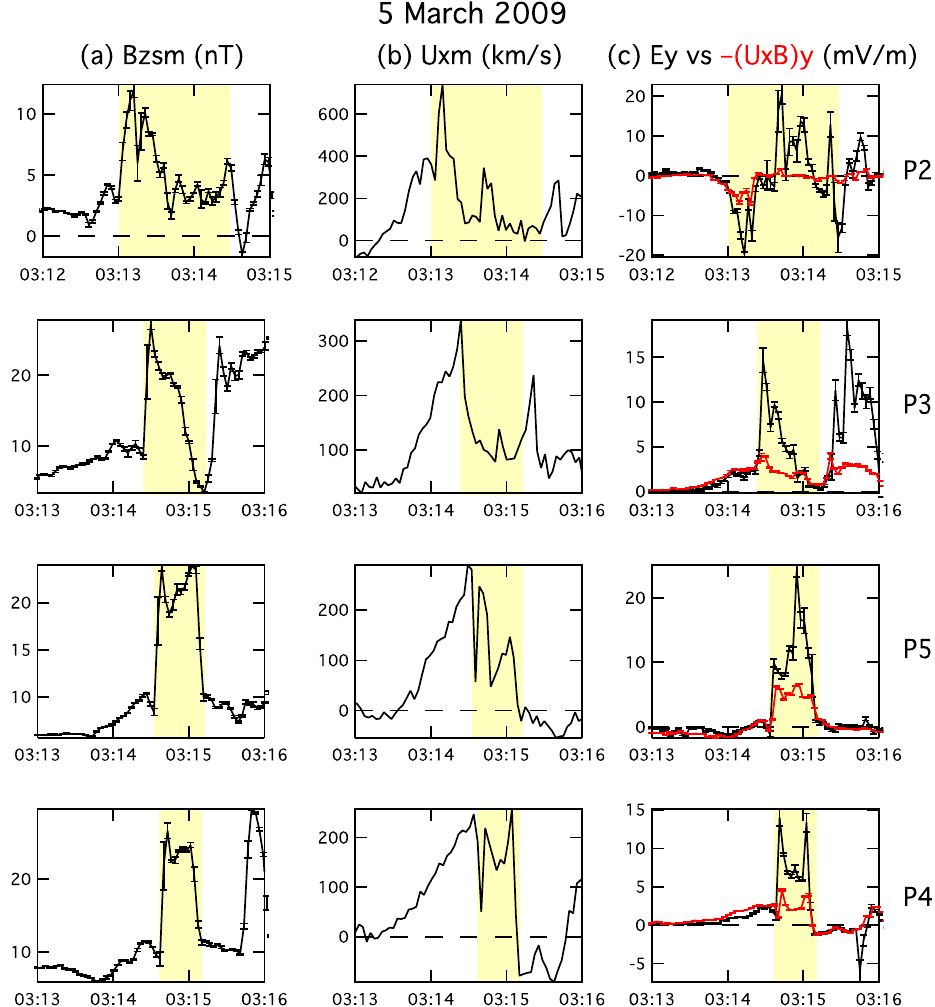
Figure 3. The B z component, plasma bulk flow Uxm, and comparison between E y and − ( U × B ) y for four THEMIS satellites on 5 March 2009. The two quantities in evaluating the FIC have significant differences.